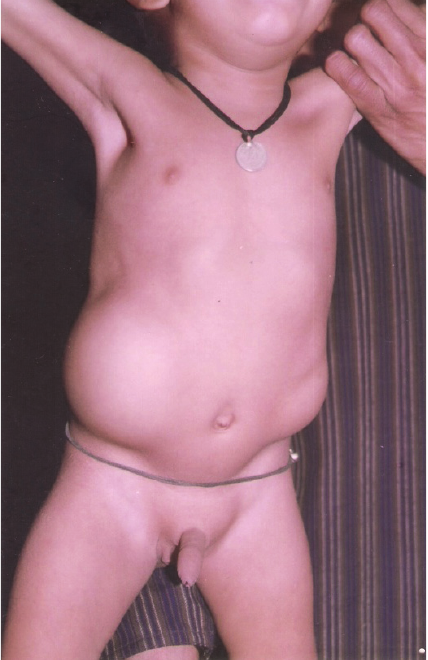
Figure 3: Bilateral congenital lumbar